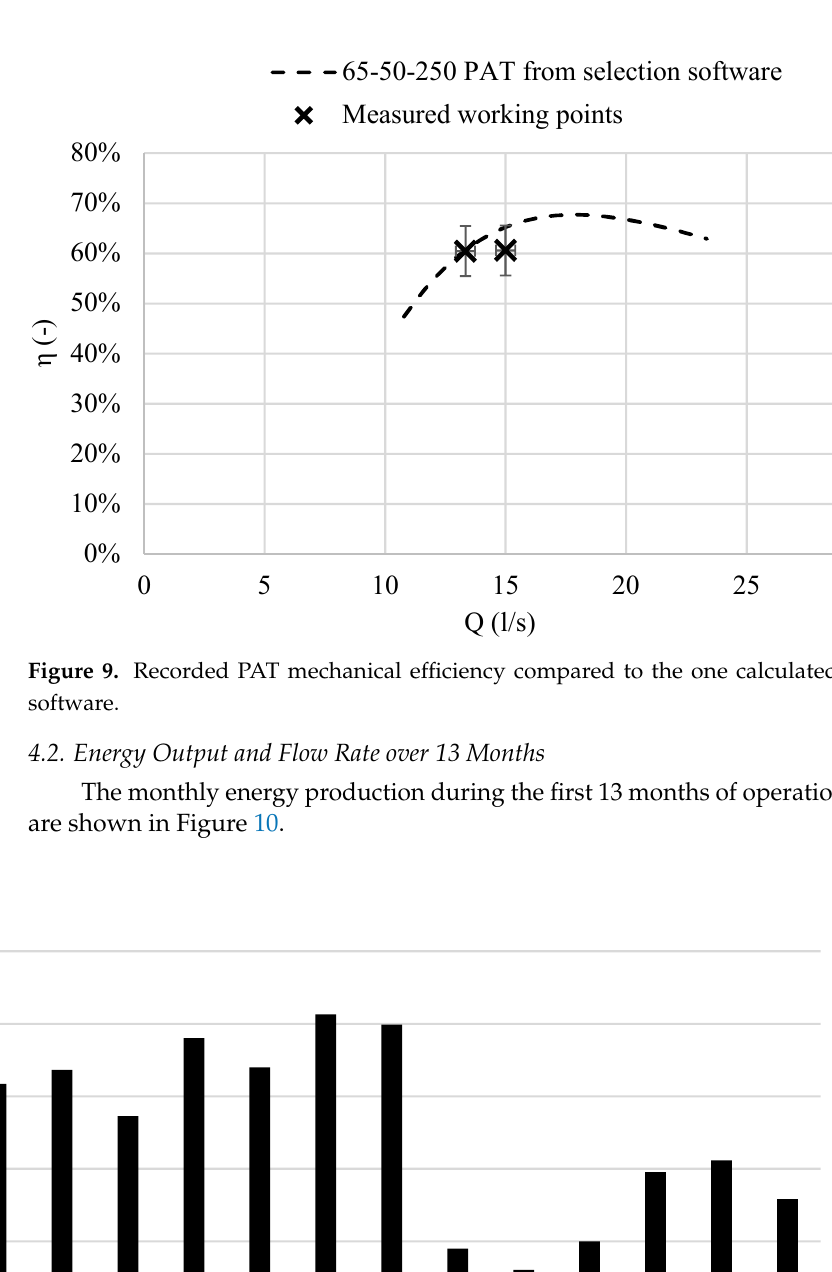
Figure 10. Monthly energy generation from the energy recovery PAT between October 2019 and